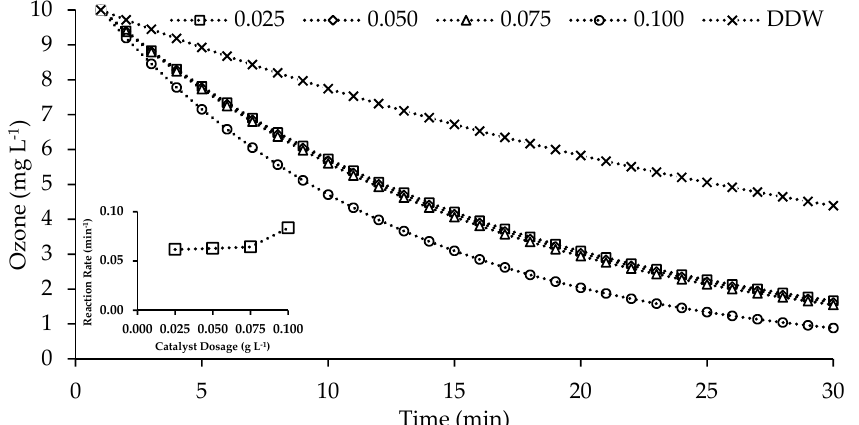
Figure 5. Promotion of ozone decomposition with different catalyst dosage (The catalyst dosages are given in g L − 1 , DDW: Deionized and distilled water, Conditions: t = 22 ◦ C, pH = 6.72, [O 3 ] = 10 mg L − 1